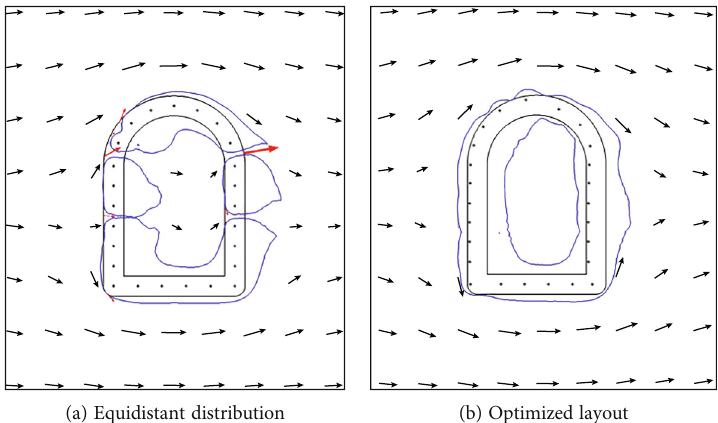
Figure 9: Frozen wall and seepage fl ow at freezing duration of 56.9